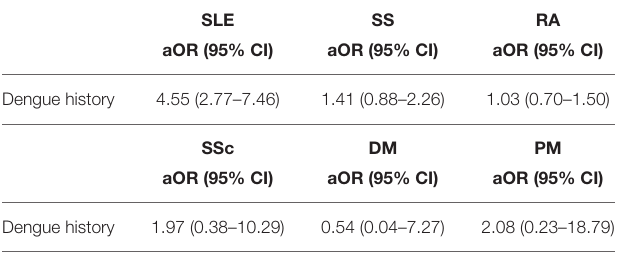
TABLE 3 | Associations between a history of dengue infection and the risk of systemic lupus erythematosus, Sjögren’s syndrome, rheumatoid arthritis, systemic sclerosis, dermatomyositis, and polymyositis.